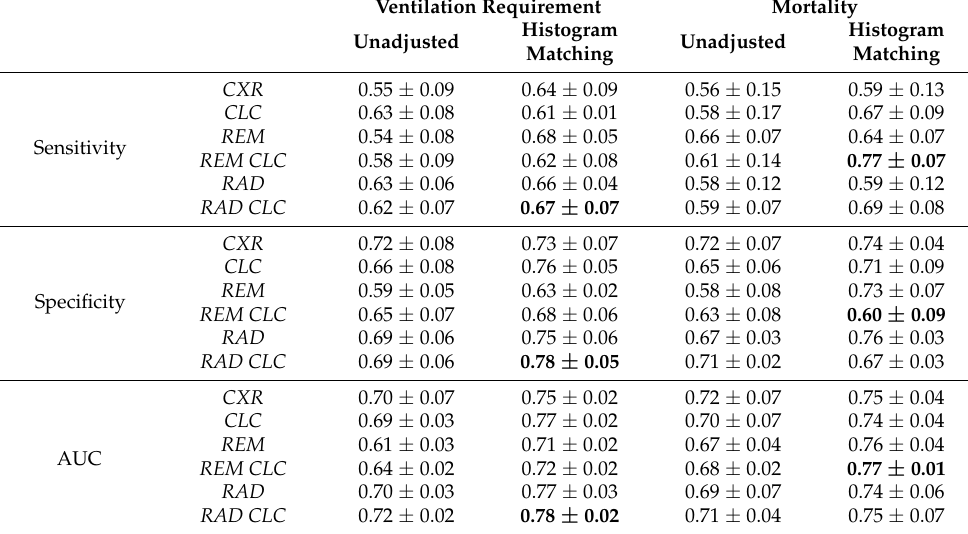
Table 6. Deep learning clinical outcome prediction results.